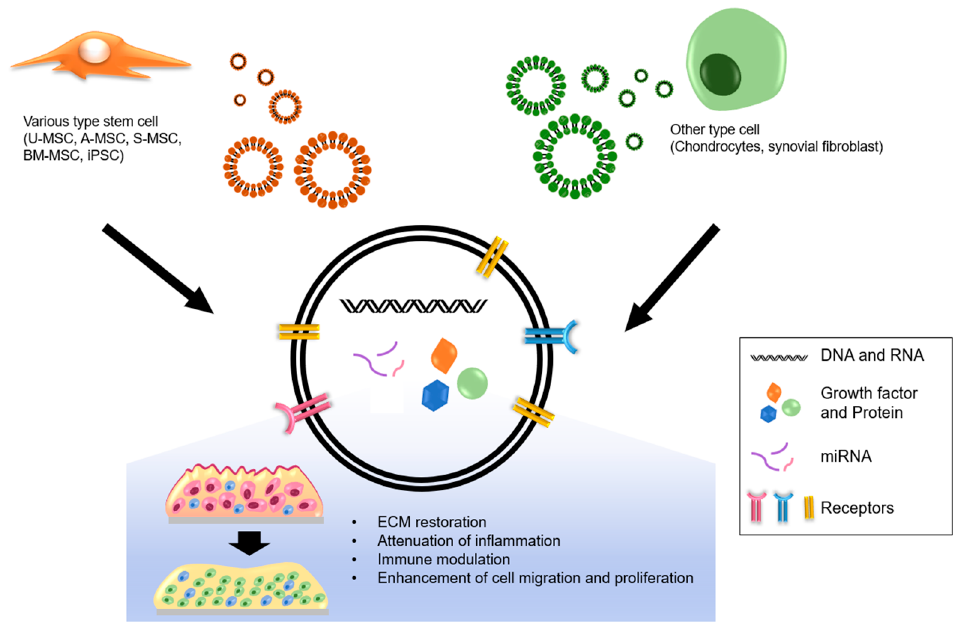
Figure 2. The exosomes and their therapeutic effects on